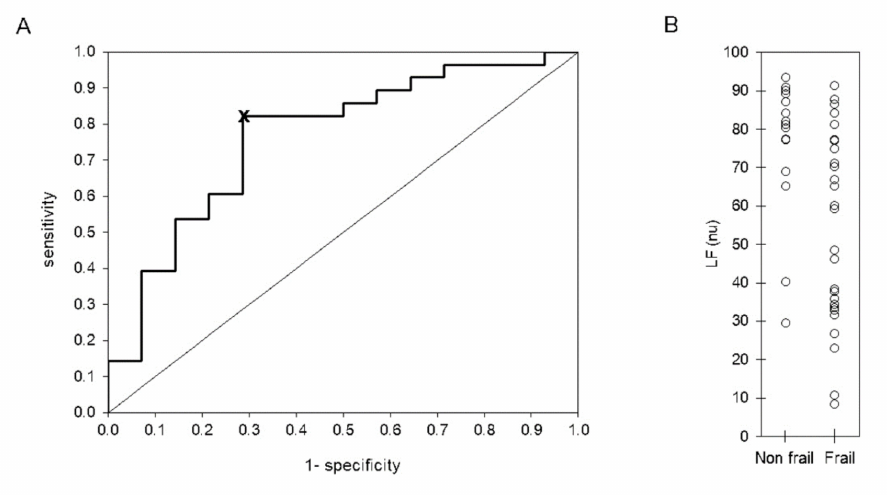
Figure 3. Receiver-operator characteristic (ROC) curve ( A ) and scatter plot ( B ) of LF (nu) evaluated during 5 min of standing rest (baseline phase) in 15 non-frail and 27 frail older adults. The best cut-off point, indicated by symbol ‘x’ in panel ( A ), was determined according to the shortest orthogonal distance from each point to the optimum vale (0,1). The line in panel ( B ) indicates the cut-off point at 77.3 normalized units